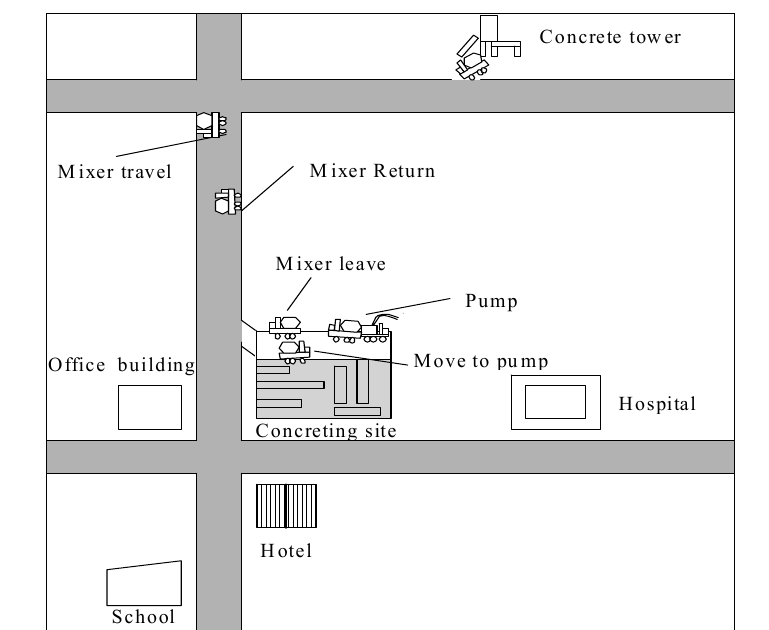
Figure 4. Illustration of each period of time T for calculating L eq-T along with simulation advancement